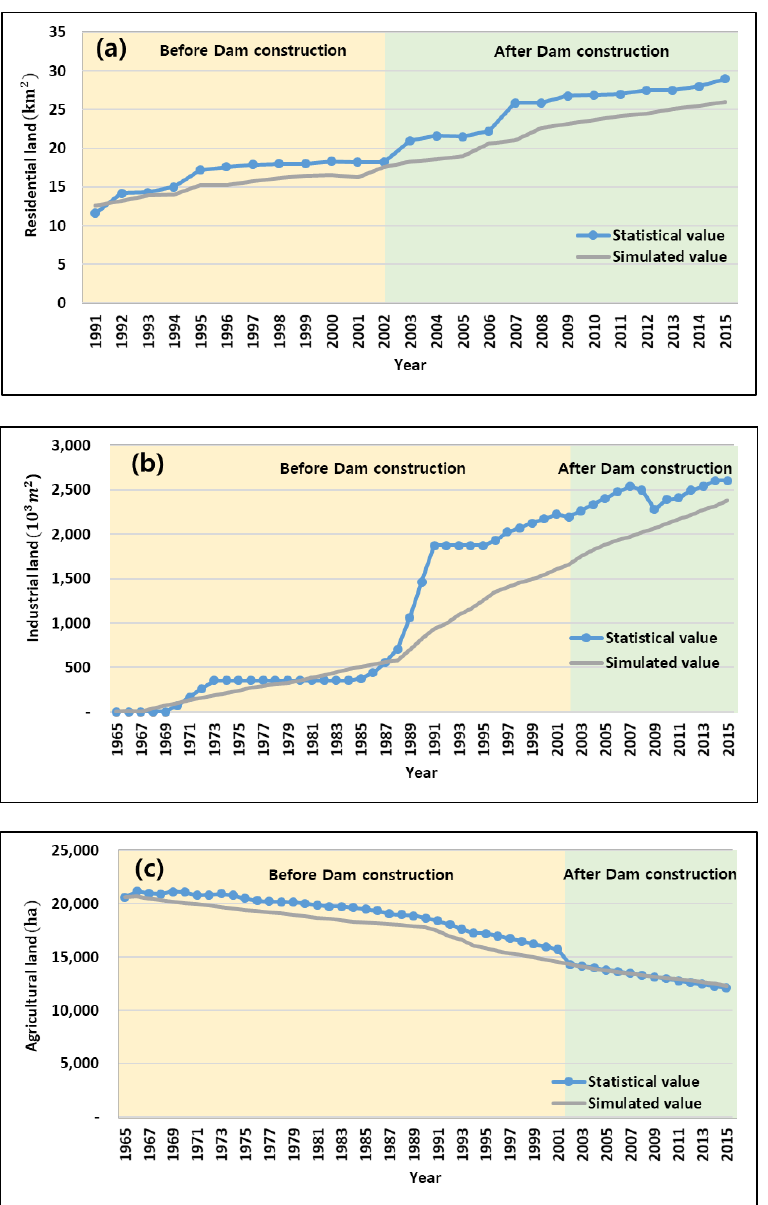
Figure 7. Calibration results—land use ( a ) residential land, ( b ) industrial land, and ( c ) agricultural